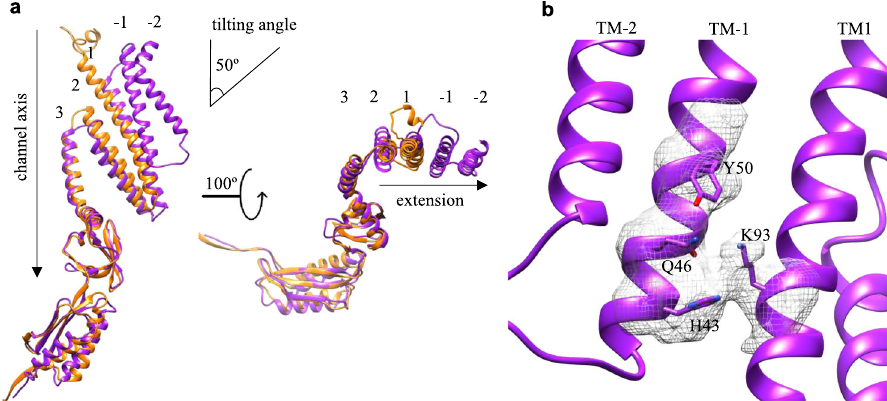
Fig. 2 Extended tilting paddle domain in YnaI. a Monomers of YnaI (purple) and MscS (PDB: 6PWN, orange) are superimposed. The paddle containing TM-2 ~2 is tilted relative to the vertical channel axis (left) and all four TMs are extended in the same direction into the bilayer (right). b Speci fi c polar residues that contribute to the stability of the paddle domain and their experimental densities (dark